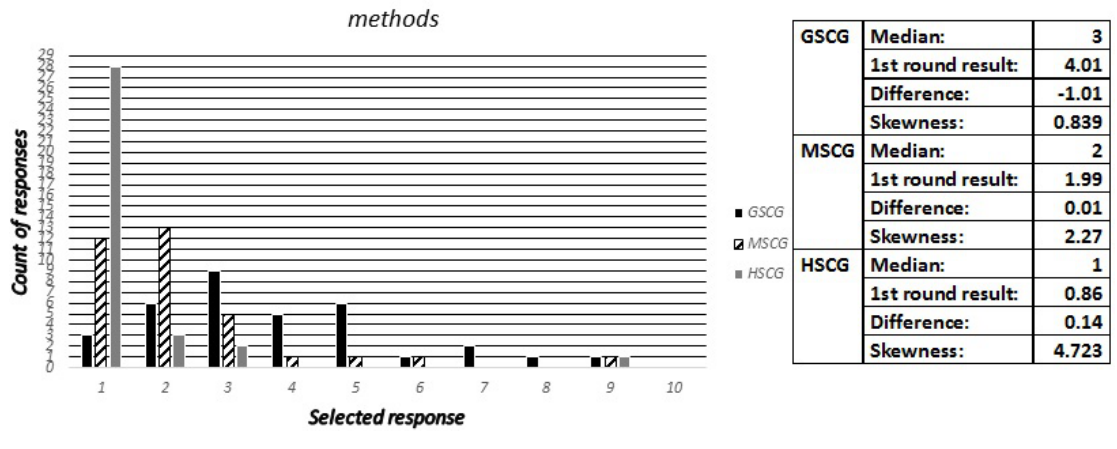
Figure 14. Expert predictions for question 10. Table 2. Expert predictions for question